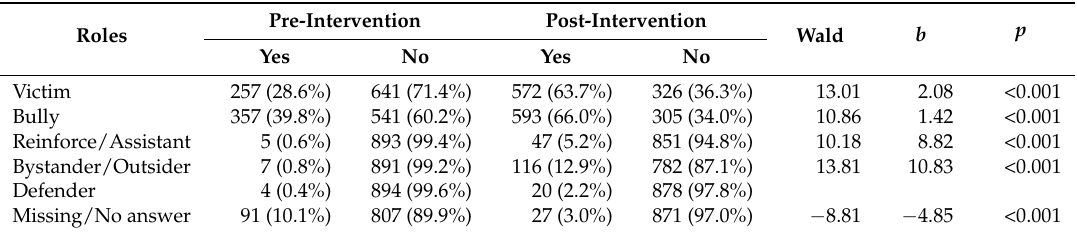
Table 2. Awareness of cyberbullying social dynamics before and after the intervention.